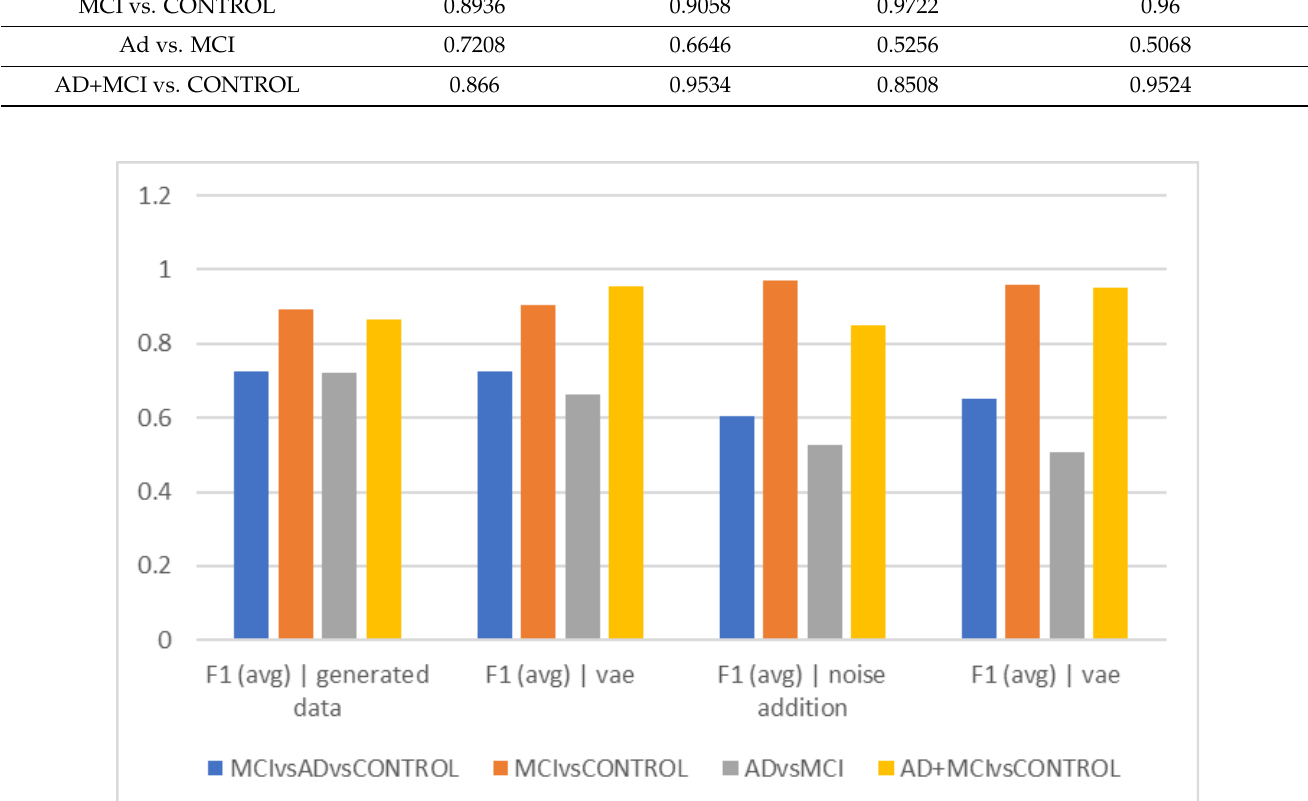
Figure 2. Comparison of results for a period of 5 s (accuracy). Table 3. Average accuracy and F1Score criteria for 50 trials for different time intervals. Results for a period of 5 s